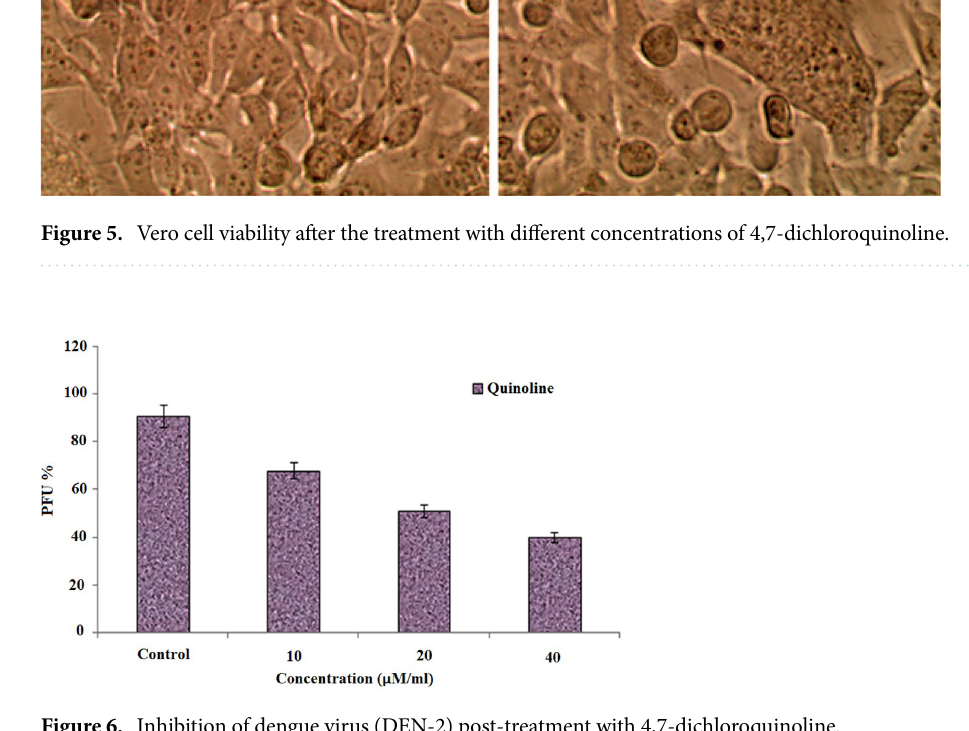
Figure 6. Inhibition of dengue virus (DEN-2) post-treatment with